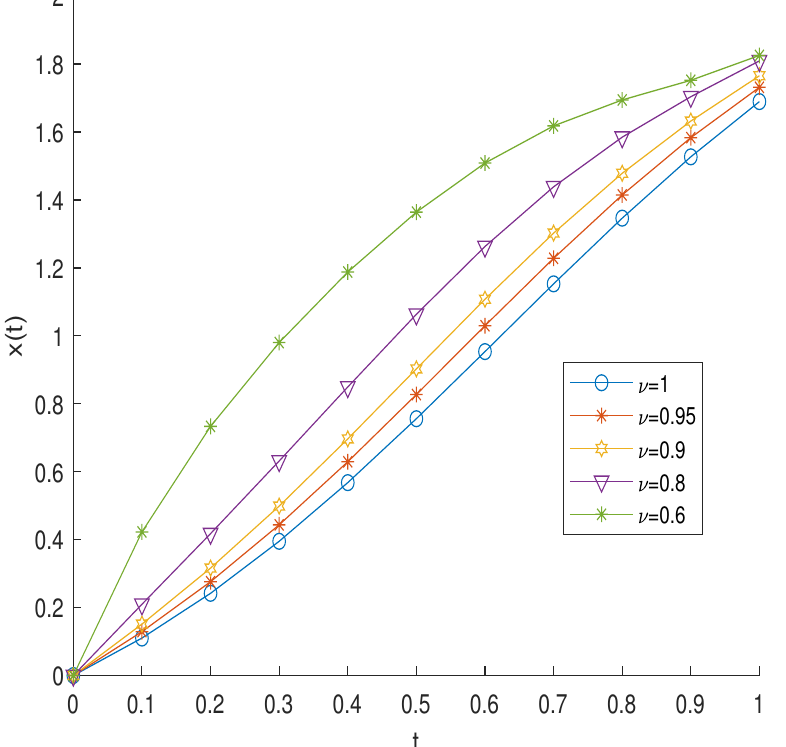
Figure 13. Approximate solutions of x ( t ) for N = 10 with ν = { 0.6,0.8,0.9,0.95,1 } for Example